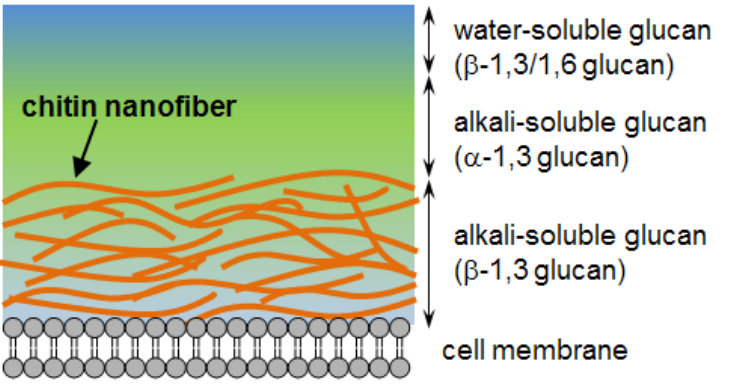
Figure 1. Schematic presentation of the cell-wall structure of a typical